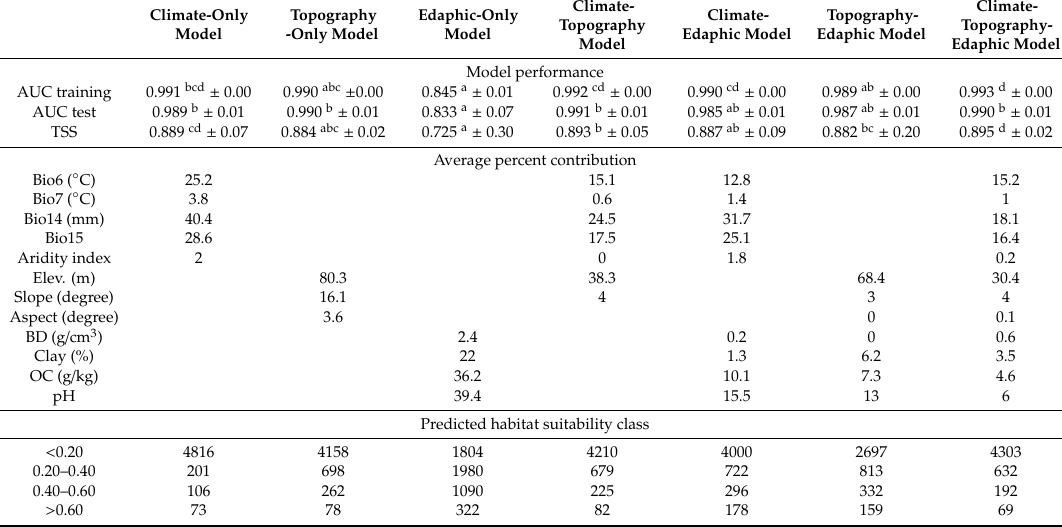
Table 2. Area under the curve (AUC) and true skill statistics (TSS) of models’ performance ( ± SD), average percent contribution of the di ff erent predictors, and predicted habitat suitability class (in km 2 ) for P. boveana under di ff erent MaxEnt